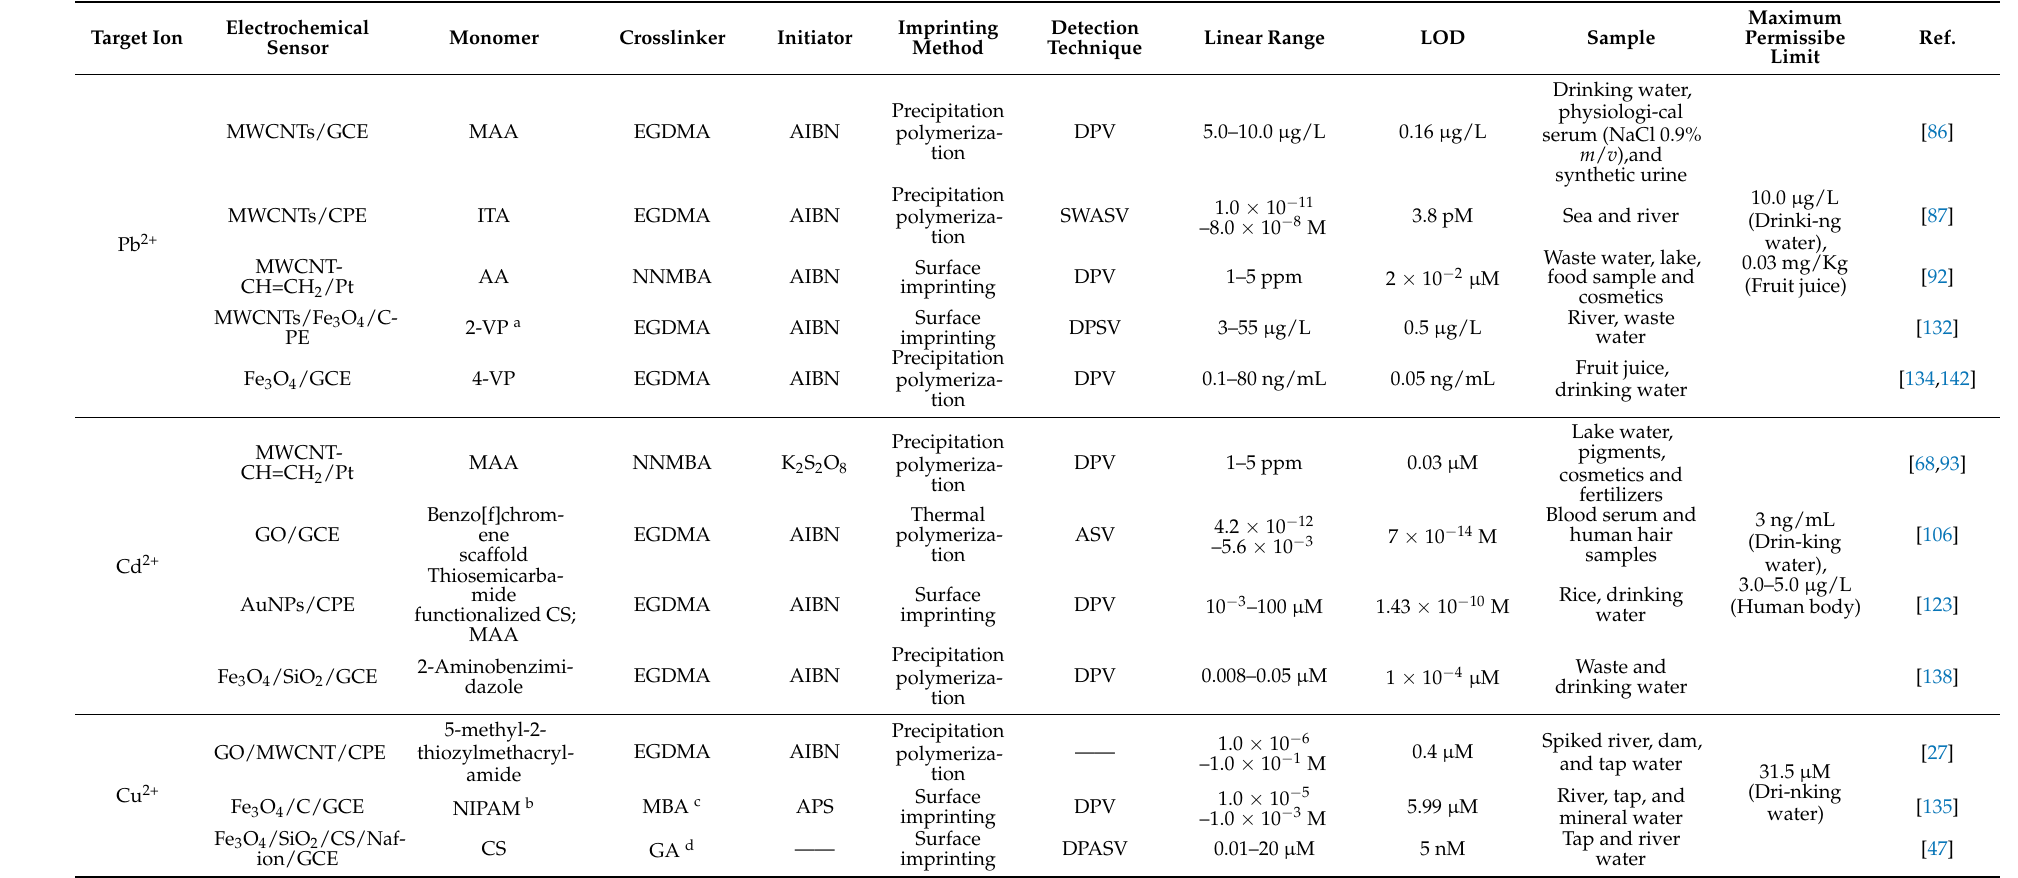
Table 4. Overview on nanomaterials-based HMIIECSs for the detection of several common